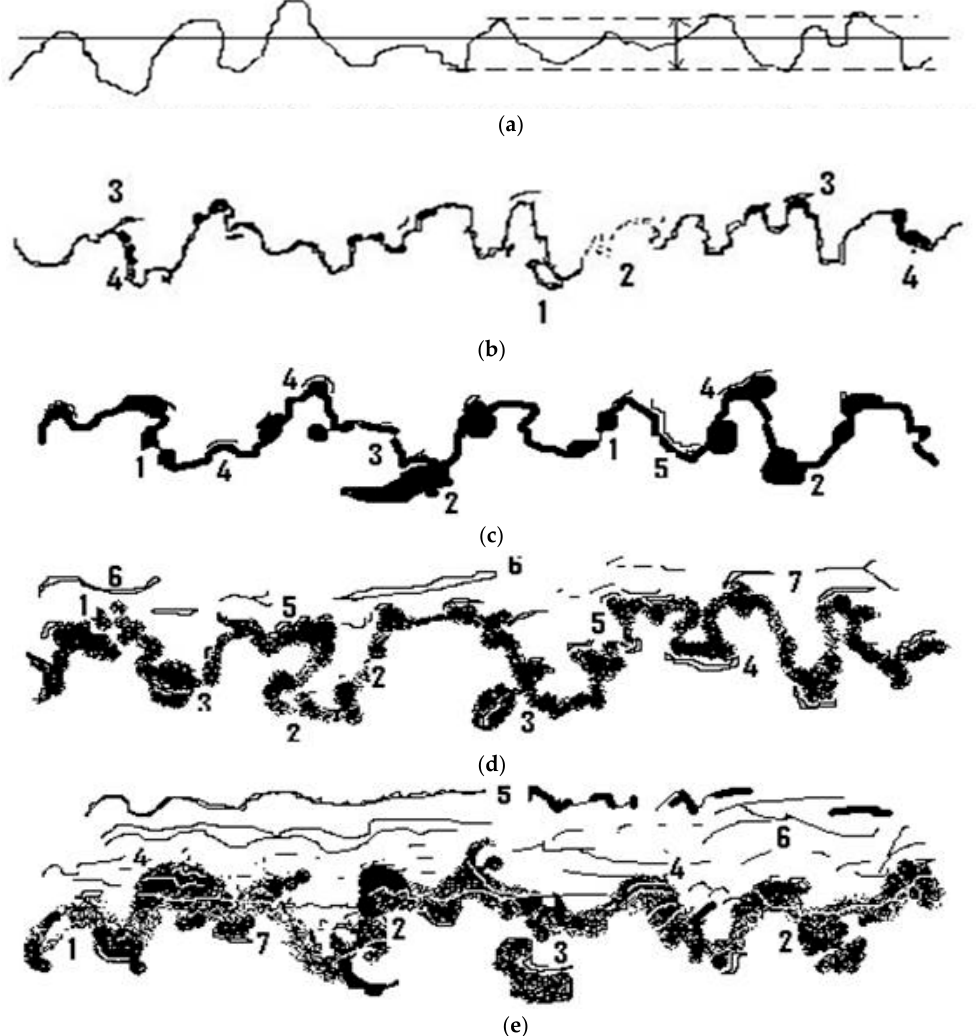
Figure 6. Phenomenological modeling of major damaging mechanisms in presence of changing TGO geometry and size under the influence of increasing numbers of thermal cycling (room temperature to 1080 °C). ( a ) As-sprayed BC-TC interface profile with roughness around 5–10 μ m; ( b ) Thermally exposed samples for 10 cycles. 1. Oxidation around ceramic island, 2. Scattered nucleation and limited growth, 3. Small cracks around peaks, 4. Adjacent nucleation and growth connected by thin ligament; ( c ) Thermally exposed samples for 100 cycles, 1. Oxide islands linked by thin ligament, 2. Uneven oxidation, 3. Discontinuous oxide growth, 4. Short cracks around peaks, 5. Long cracks along interface; ( d ) Thermally exposed samples for 430 cycles; 1. Divorced islands of oxide, 2. Thin TGO links, 3. Massive oxide growth with fine cracks, 4. TGO-BC interface separation, 5. Series/discrete cracking at TGO-TC interface, 6. Long TC cracking, 7. Cracks around TGO peaks; ( e ) Thermally exposed samples at delamination, 1. TGO growth around ceramic island, 2. Complex profile of TGO at both edges, 3. Separated TGO islands with cracks at interface, 4. Series of transverse parallel cracks, 5. Long cracks in TC parallel to TGO, 6. Extensive cracking network in TC.